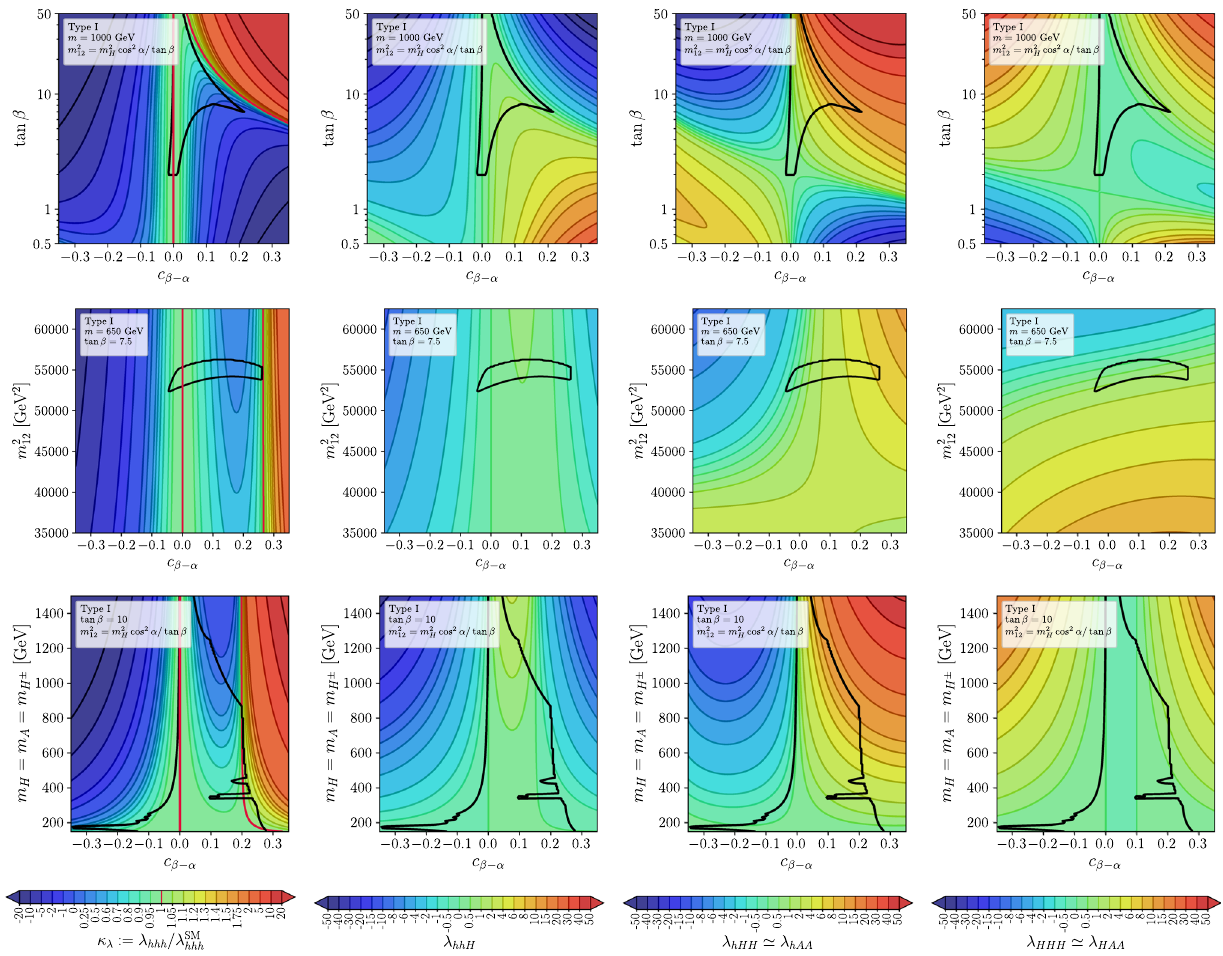
Fig. 3 Predictions for κ λ = λ hhh /λ SM (left), λ hhH (2nd column), Shown as solid black lines are the exterior boundaries of the parameter λ (cid:7) λ λ (cid:7) λ space regions that are allowed taking all theoretical and experimental hHH hAA (3rd column) and HHH HAA (right) in the 2HDM constraints (see text). The red lines in the left column indicate κ λ = type I benchmarks planes 1 (upper row), 2 (middle row), 3 (lower row).